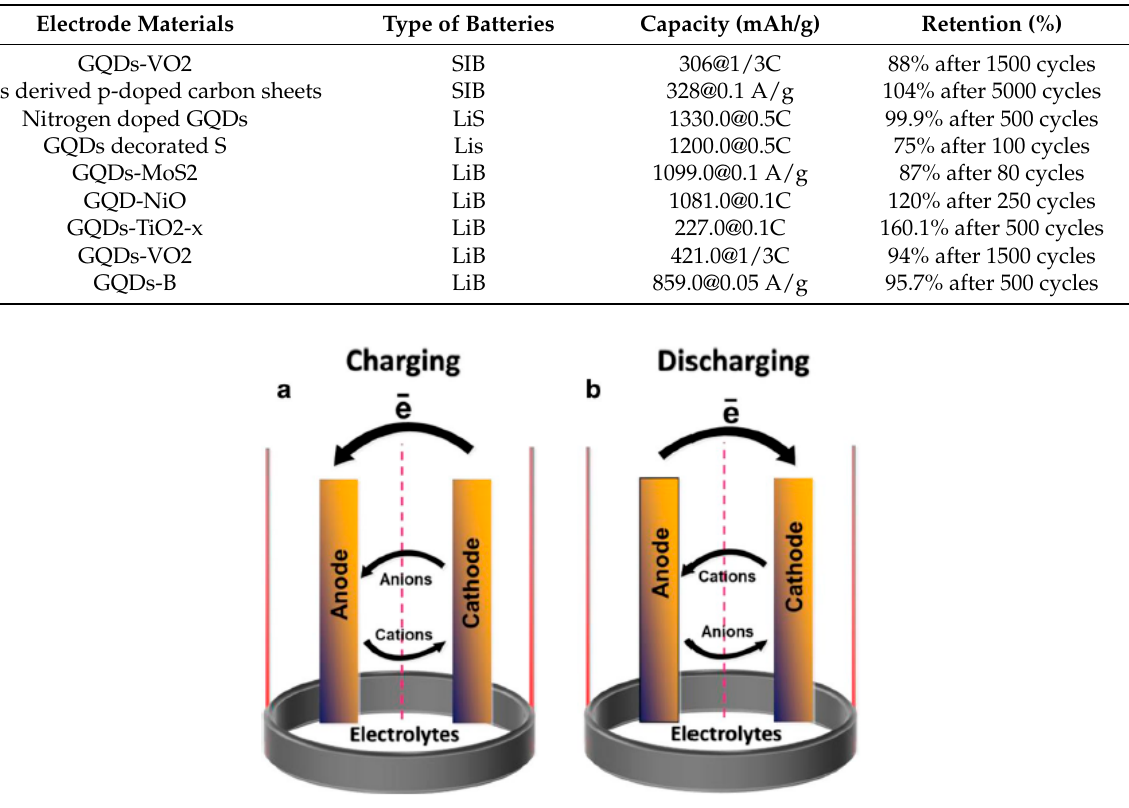
Figure 15. Schematic illustration with general mechanism of ( a ) charging and ( b ) discharging process in batteries. Reprinted with permission from Ref. [100].